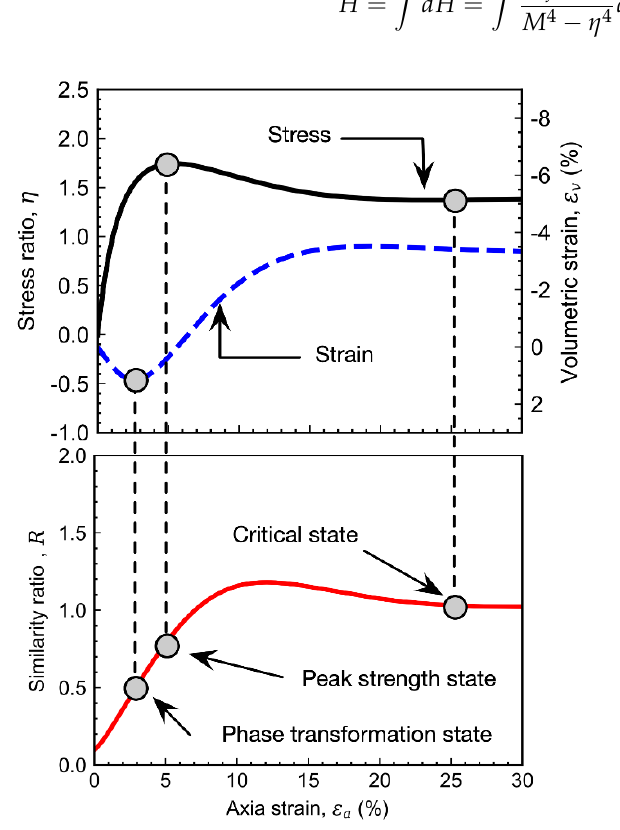
Figure 4. The schematic diagram of sub-loading and normal yield surfaces.